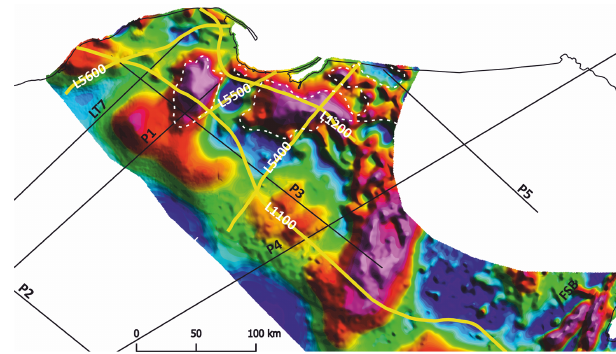
Figure 3. Location of the PolandSPAN ™ seismic profiles on the background of a total magnetic field anomaly map of NE Poland (reduced to pole) (data compilation of Stanisław Mazur). The lo- cation of the AMCG complexes from Fig. 2 is also indicated by a white dashed line.